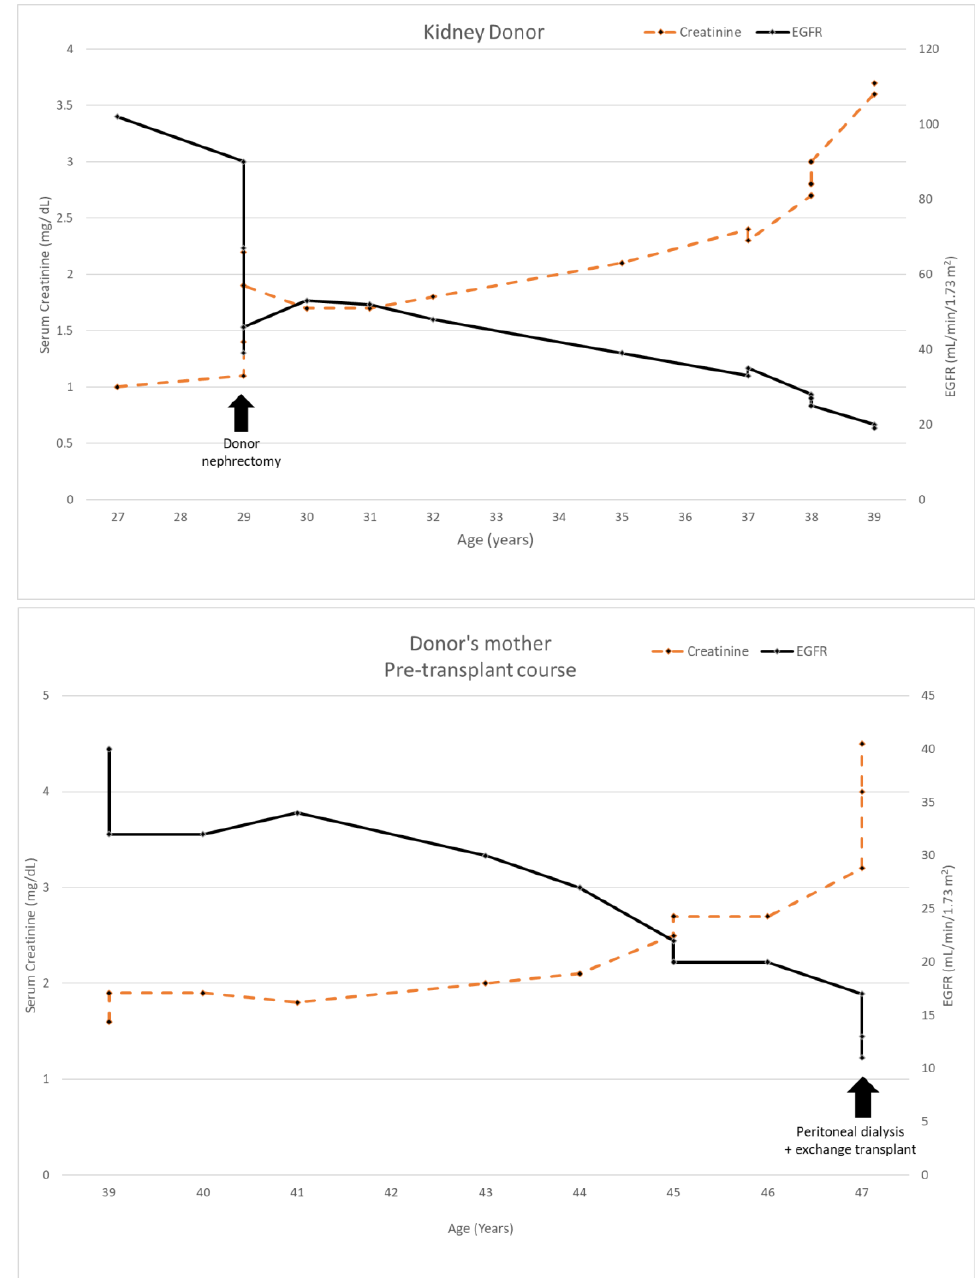
Figure 1. Serum creatinine and EGFR of kidney donor 1 compared to his mother’s clinical course.